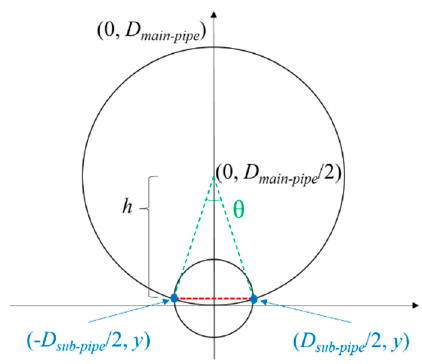
Figure 8. Geometry between the main pipe and sub-pipe.